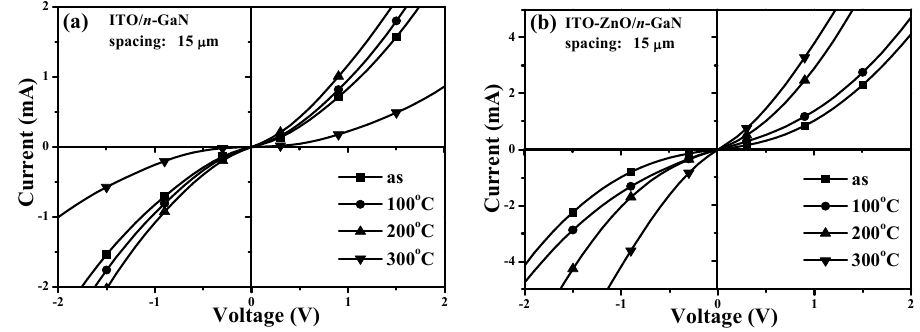
Figure 3. I-V curves of the ( a ) ITO/ n -GaN and ( b ) ITO-ZnO/ n -GaN contact systems processed by various annealing temperatures for 1 min under vacuum ambient, measured from the contact spacing of 15 μ m.